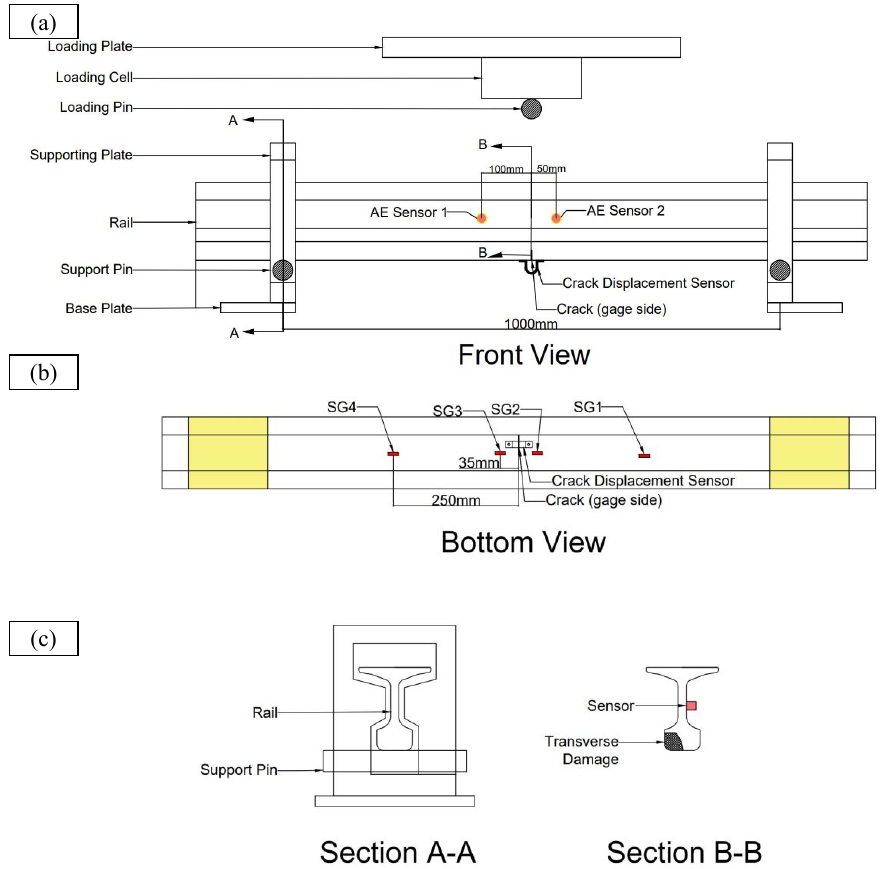
Figure 4. Schematics for experimental setup ( a ) front view ( b ) Position of strain gauge, crack and crack displacement sensor ( c ) End support and position of AE sensor.